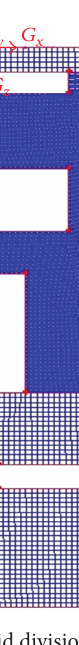
Figure 2: Grid division in virtual